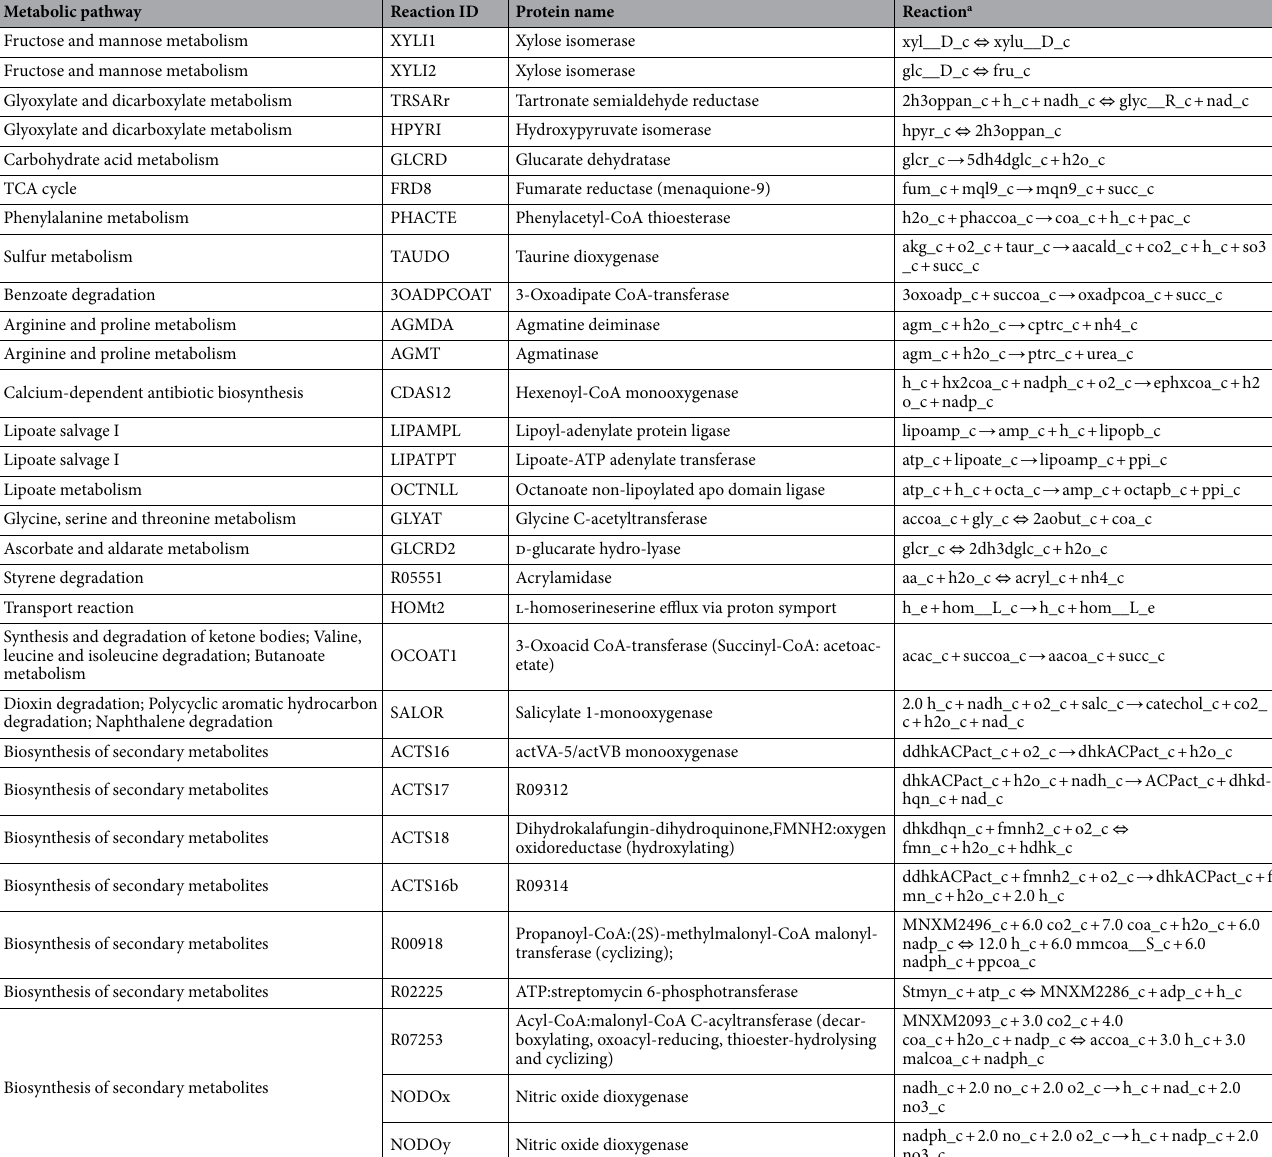
Table 3. List of 30 biochemical reactions available in SrapWT2040 (wild-type), but absent in SrapUV2010 (SRMK07 strain). a Metabolite abbreviations: